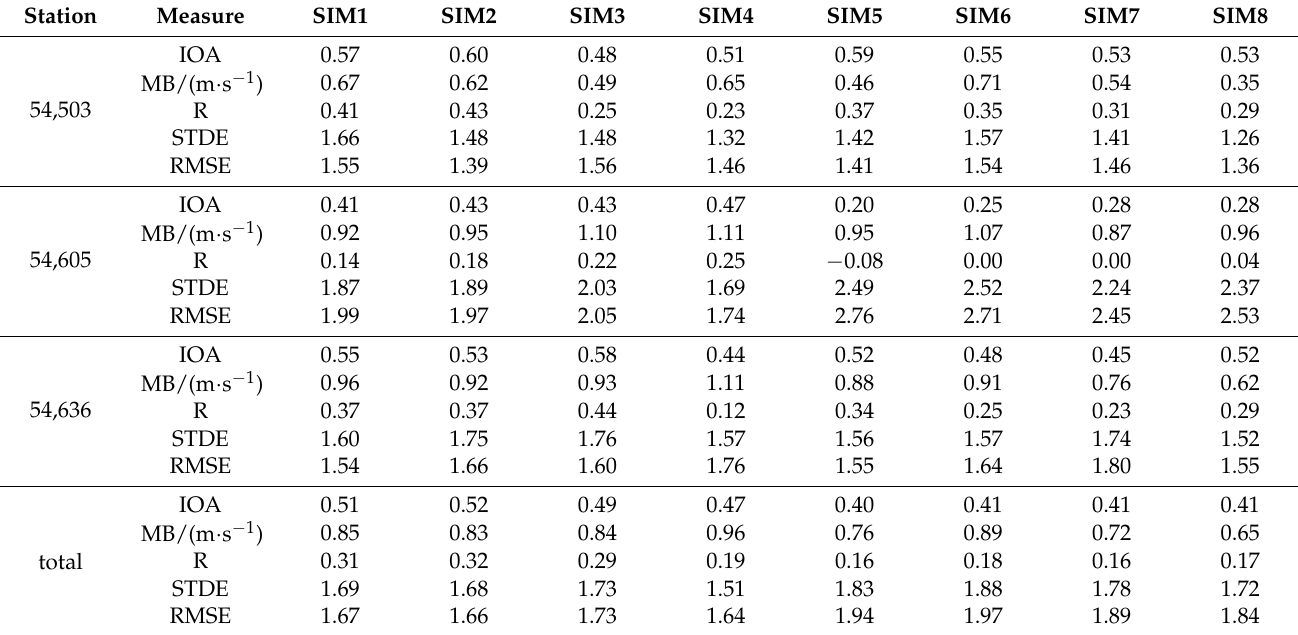
Table 4. The 10-m wind speed in the Xiongan New Area from observations and eight combined scheme